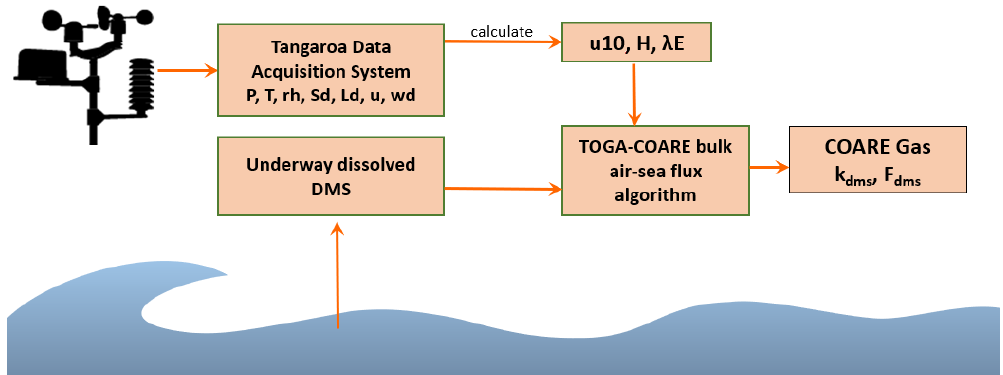
Figure 2. Summary of the processing scheme of the meteorological measurements (pressure ( P ), temperature ( T ), relative humidity (rh), wind ( u ), wind direction (wd), short- and longwave downwelling radiation (Sd, Ld)) from the AWS and radiometers measurements that were stored in the Tangaroa data acquisition system. Wind corrected to 10m ( u 10 ), heat flux ( H ), and latent heat ( λE ) were derived from these measurements and then, together with measured dissolved DMS concentrations, used to derived the sea–air fluxes of